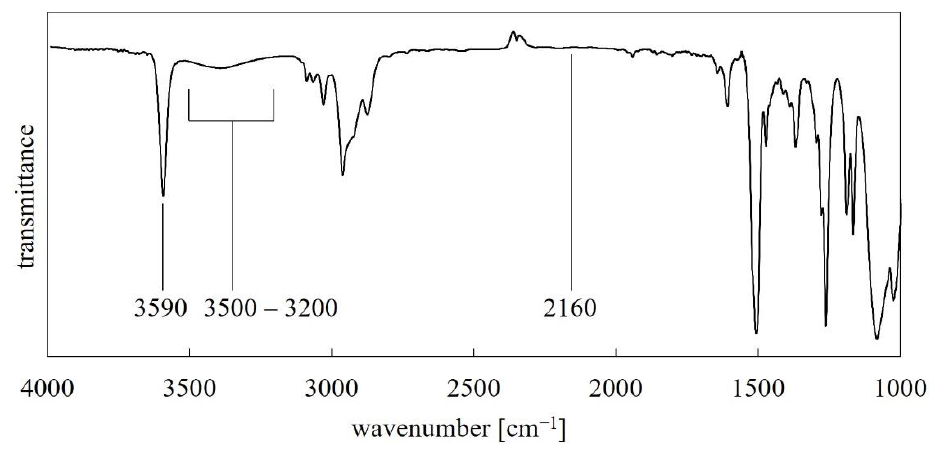
Figure 5. FT-IR spectrum of PMFOS.